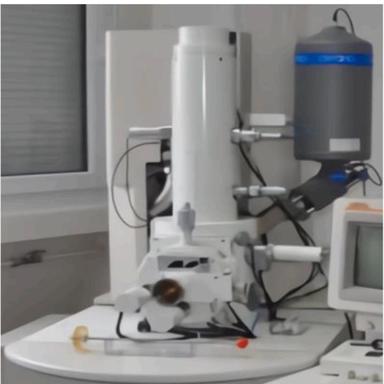
Scanning electronic microscope.